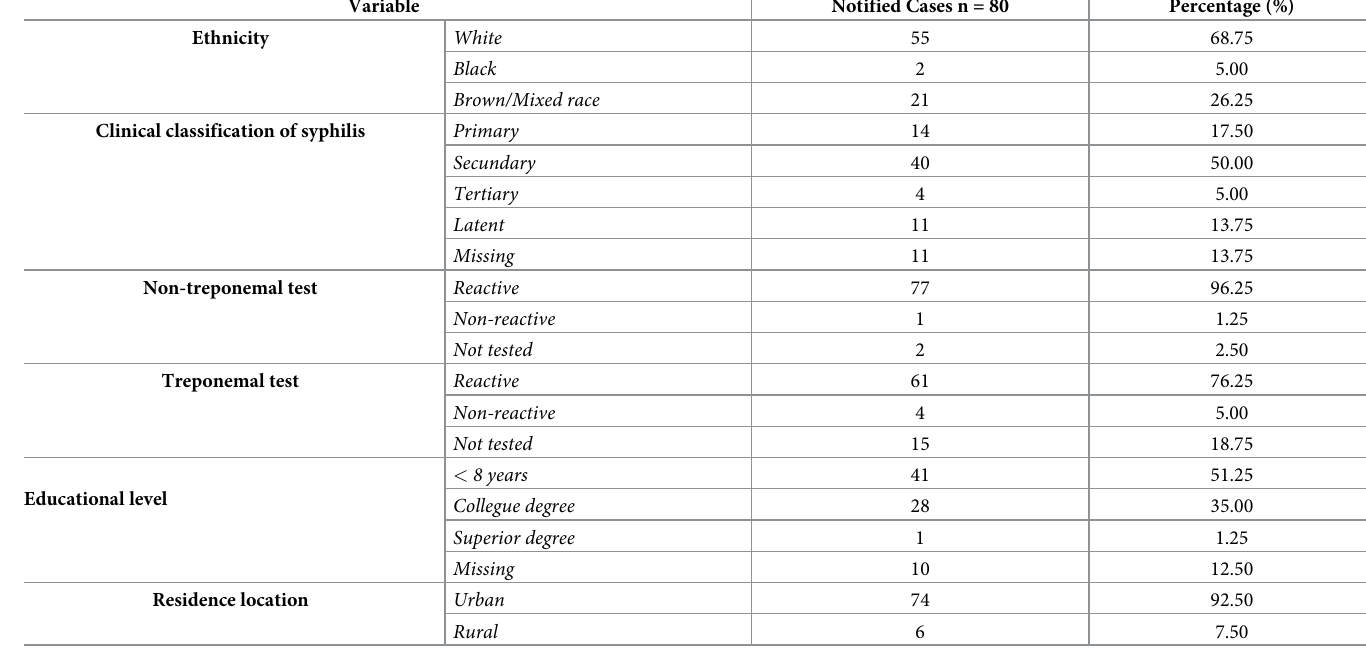
Table 4. Variables related to mothers diagnosed with gestational syphilis (GS), from 2007 to 2013 living in cities located in the Pontal do Paranapanema region. A total of 80 cases of GS were notified by cities analyzed. Pregnant women affected by syphilis were mostly white (68.75%). Fifty percent of cases were diagnosed during sec- ondary stage, followed by primary (17.50%), next latent (13.75%), then tertiary (5%). Non-treponemal test (screening test) was reactive to 96.25% of pregnant women infected whilst Treponemal test (confirmatory test) was reactive to 76.25% and not performed in 18.75% of late confirmed cases. Educational level was related to GS occur- rence in this population, since 86.25% of them studied less than 10 years. Most of pregnant women lived in urban areas (92.45%). Database: National System of Aggrava- tions and Notification–SINAN